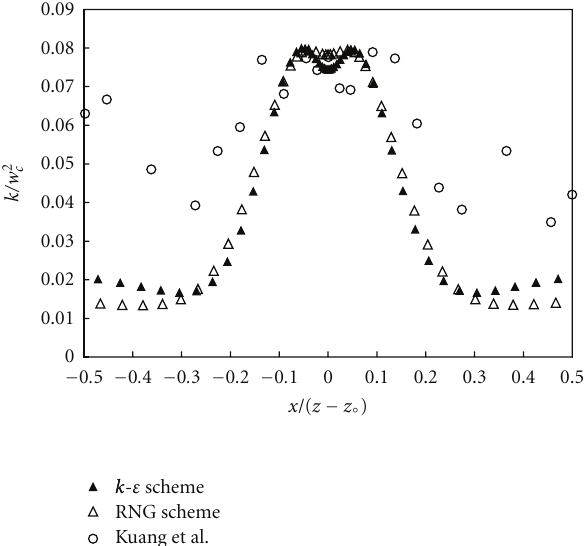
Figure 13: Profiles of turbulent kinetic energy in ZSI ( z/d = 110).